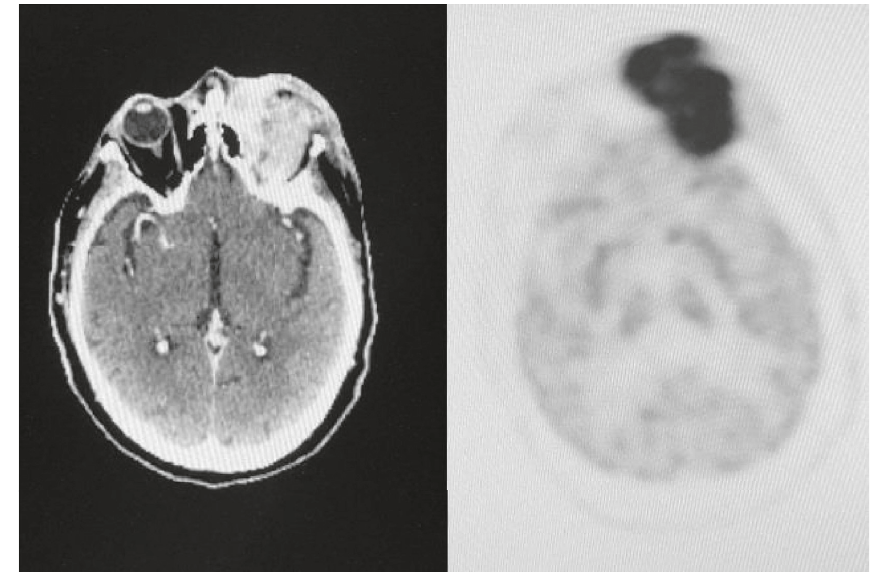
Figure 1: The FDG-PET/CT scan at relapse showed a huge tumor mass with high metabolic rate.